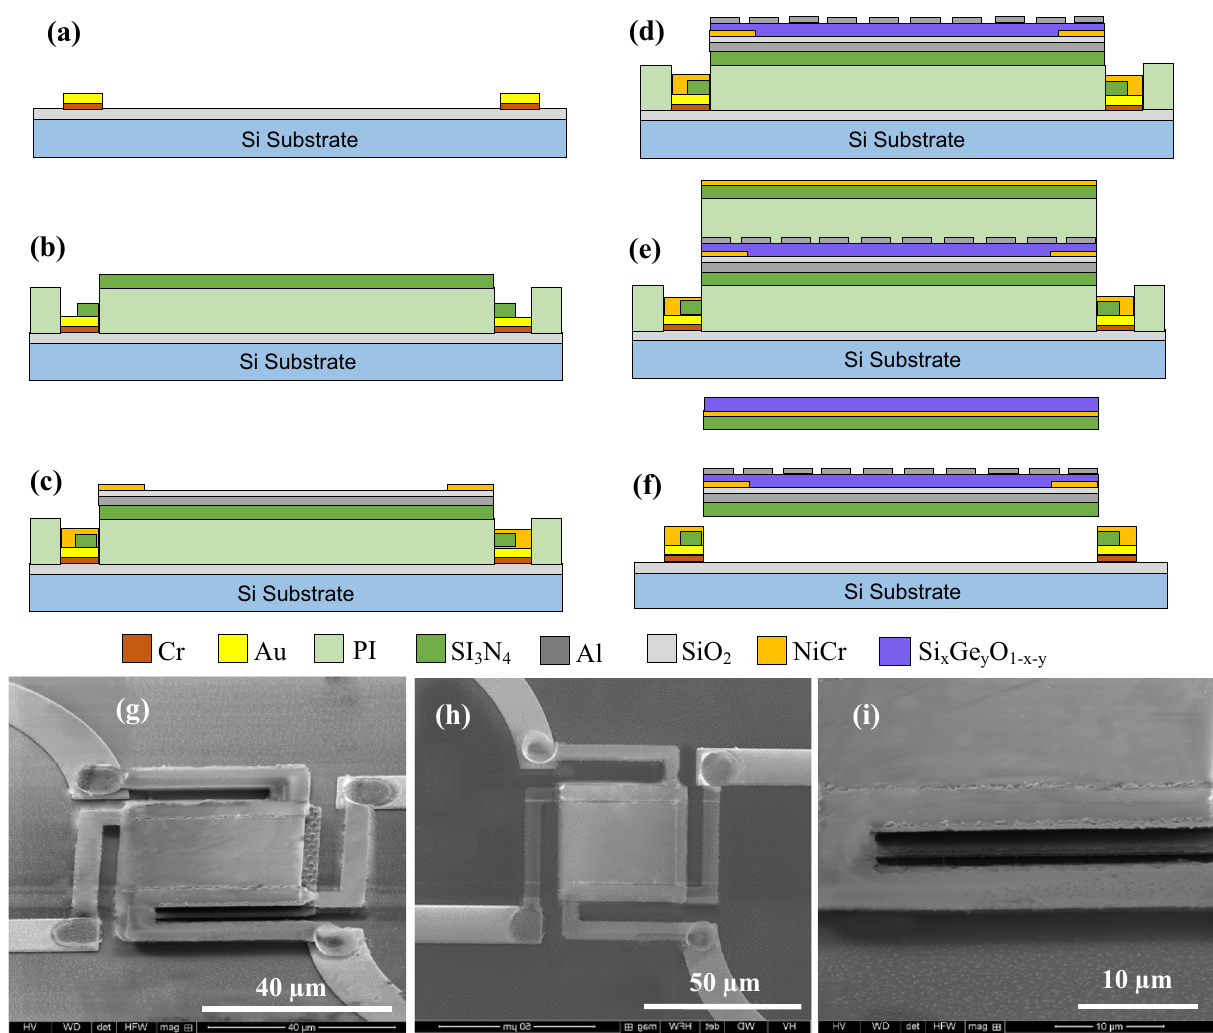
Figure 2. ( a – f ) Cross sectional view showing the fabrication steps of the two-microbolometer stack and ( g – i ) SEM micrographs of the fabricated two-microbolometer stack (left: tilted view, center: top view, and right: zoomed view of the